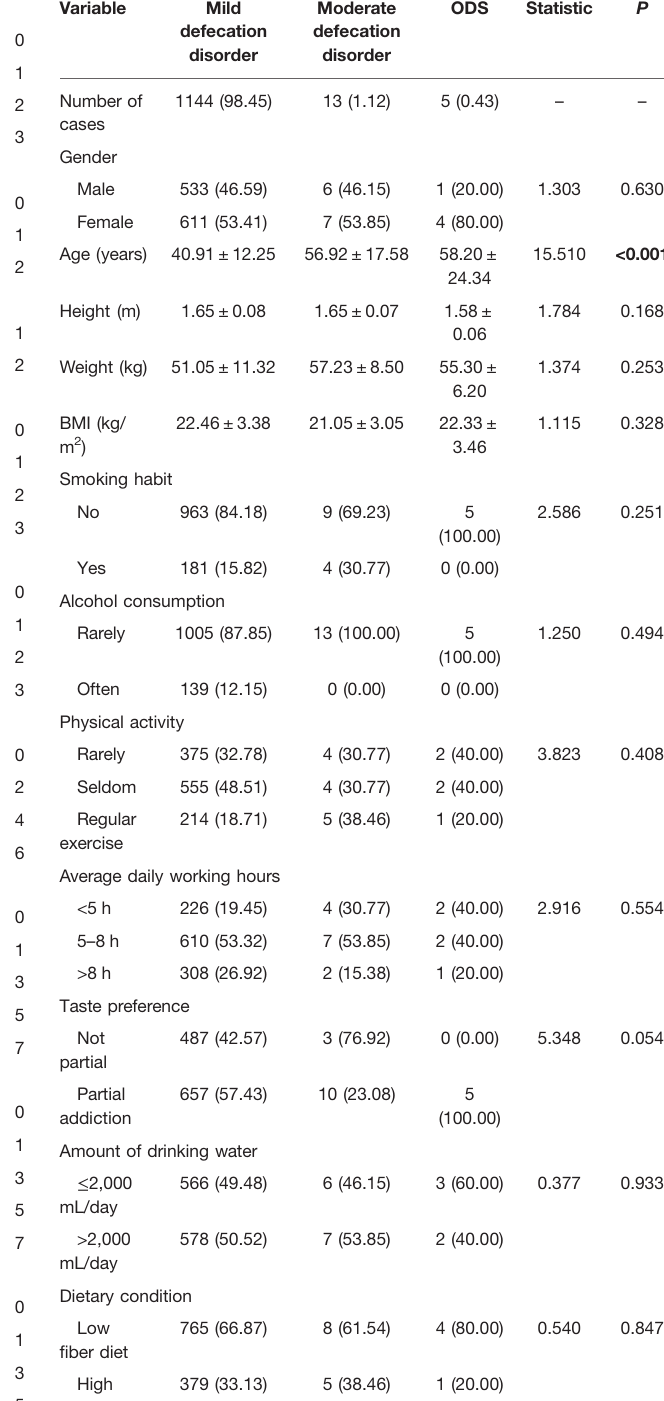
TABLE 1 | Obstructed defecation score.